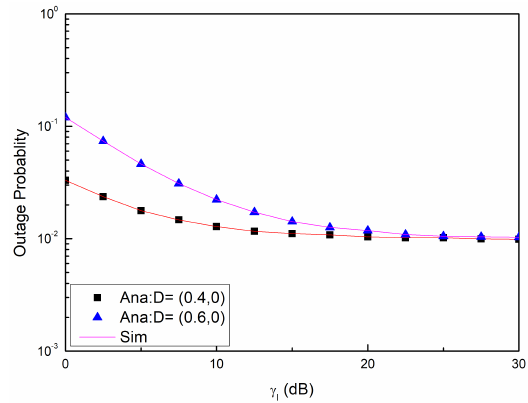
Figure 3. The impact of backhaul reliability on system performance (K=2) adding moving small cells in vehicular networks and decreasing the distance between receiver and small cells result in a significantly better system performance.